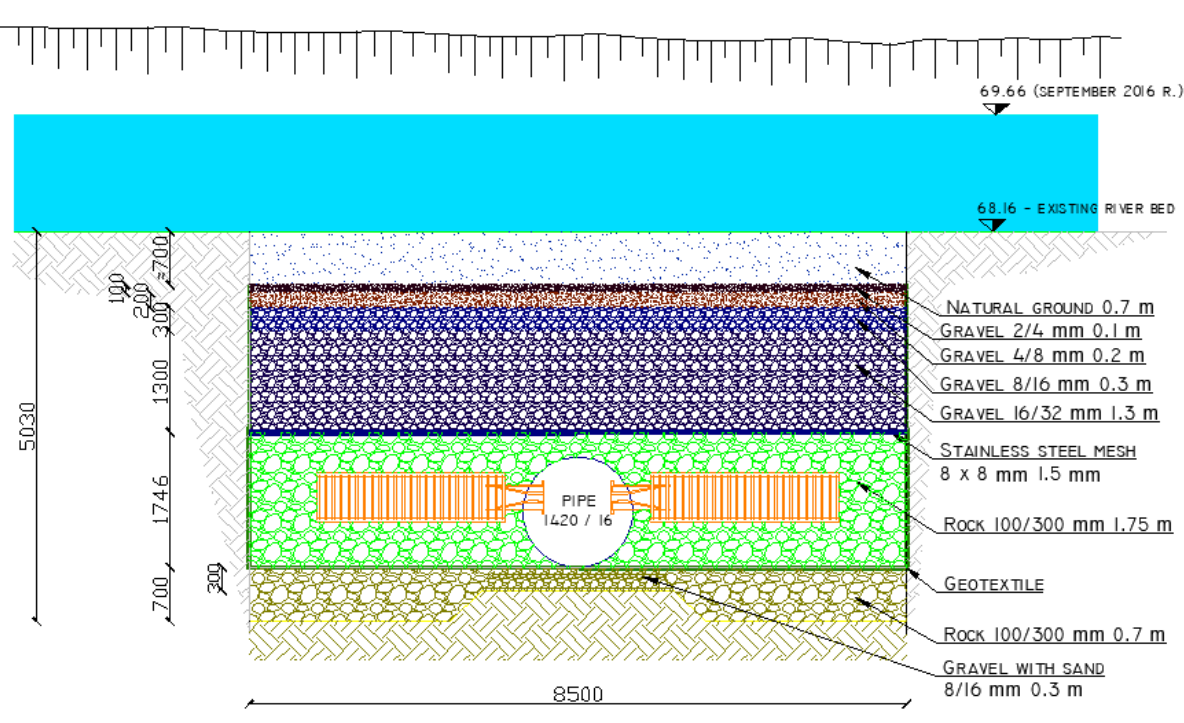
Figure 4: Cross section of the discharge installation, dimensions in mm [14].